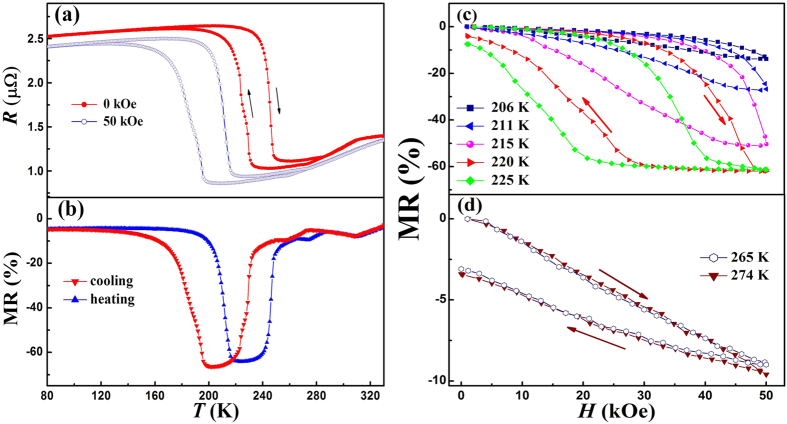
(a) Temperature dependence of resistance at 0 and 50 kOe for Ni50Mn34In15.5xAl0.5 alloy. (b) MR under a magnetic field of 50 kOe upon heating and cooling. (c,d) Field dependence of the MR at selected temperatures. Arrows indicate the direction of temperature and field variation.